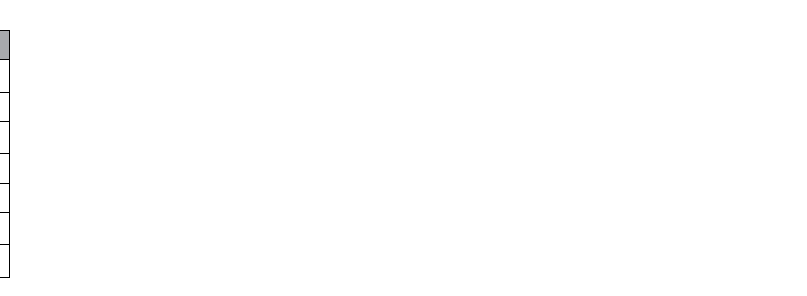
Figure 6. Boxplots of the absolute values of different deformation indexes and coefficient f two groups of regular heads and heads with DP.